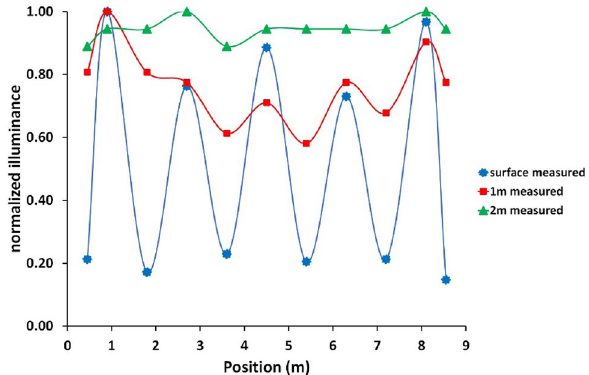
Figure 5. Illuminance measurement of final design. Normalized illuminance distribution measured at the surface and 1 m and 2 m water depth for the 6 lx extreme skyglow treatment with adjusted dimming. For numerical values see table S2.